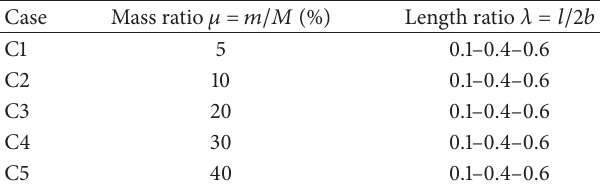
Table 1: Cases studied in the multibody